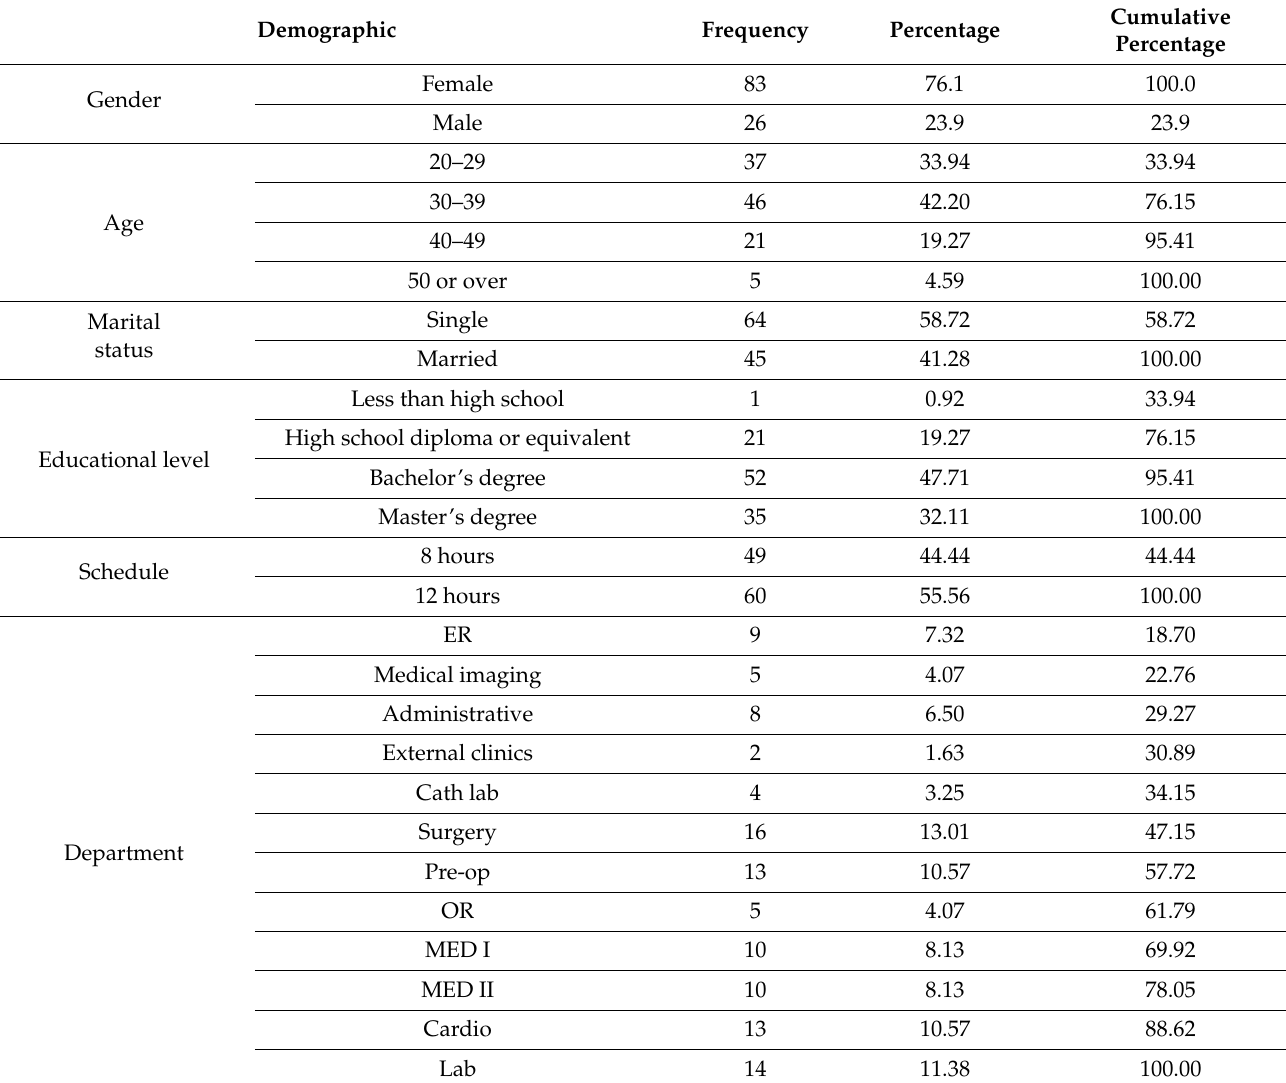
Table 4. Demographic factor analysis for